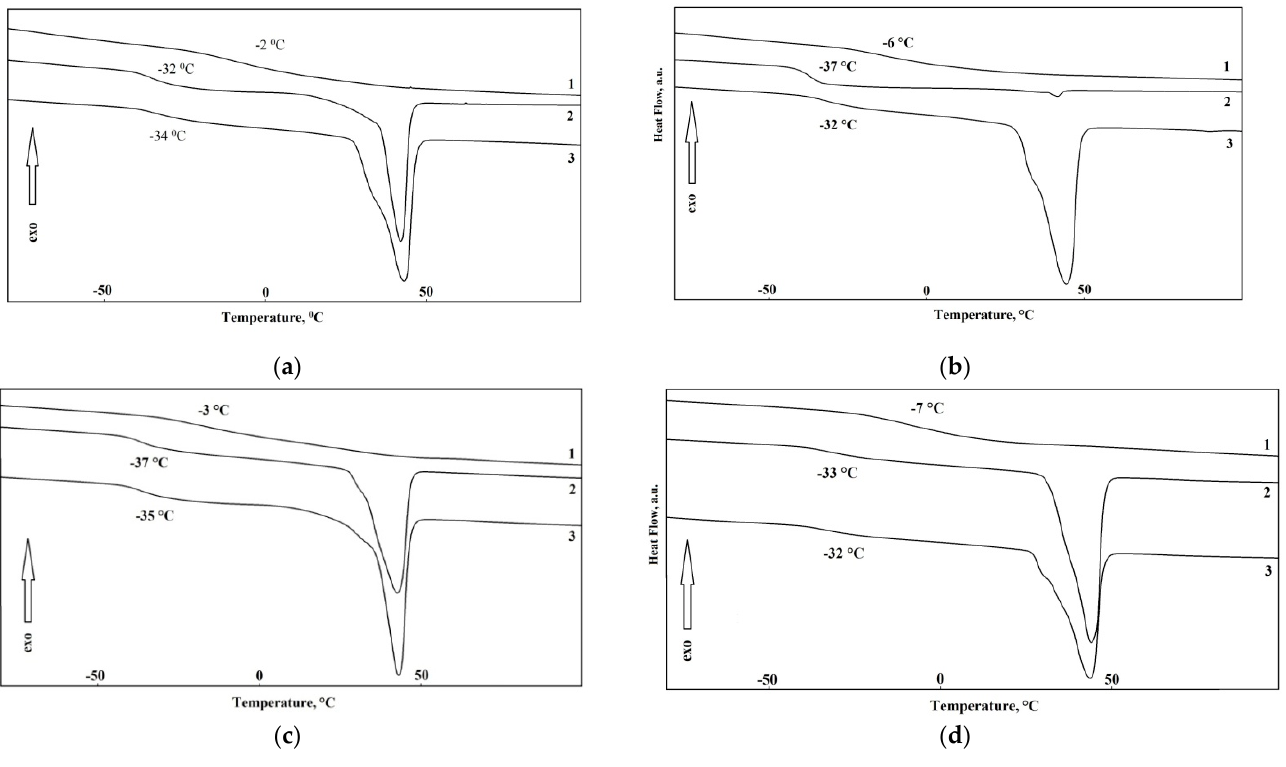
Figure 5 . DSC-curves of the epoxy urethane samples from: ( a ) HS-1, isophorone diamine and dif-